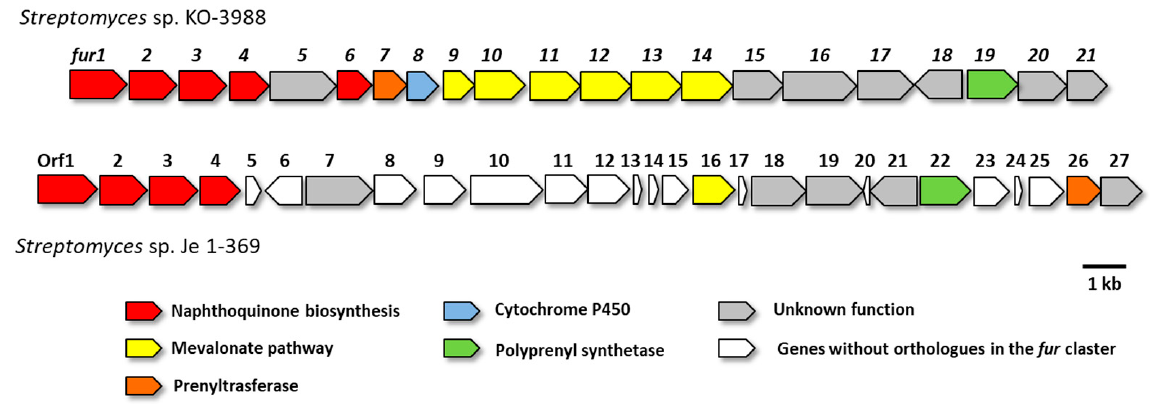
Figure 3. Comparison of the furaquinocin B biosynthetic gene clusters from Streptomyces sp. KO-3988 and Streptomyces sp. Je 1-369. Table 3. Identified ORFs, their putative gene functions, and their respective homologs in the furaquinocin ( fur ) biosynthetic gene cluster.